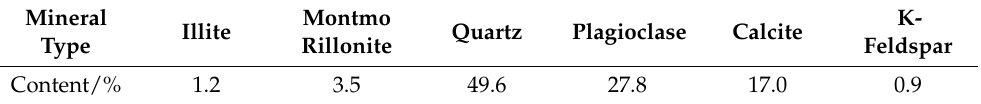
( b ) Figure 5. Change of oil drop size under different flow rate. ( a ) Comparison of maximum width of oil drop; ( b ) Comparison of maximum height of oil drop. In the case of external fluid flow, the oil drop discharge process was faster. The growth rate of oil drop in height and width was faster than that without fluid flow. The height of the oil drop increased more obviously, which was helpful for oil drop to sepa- rate from the solid surface. When there was an external fluid flowing, there would be a